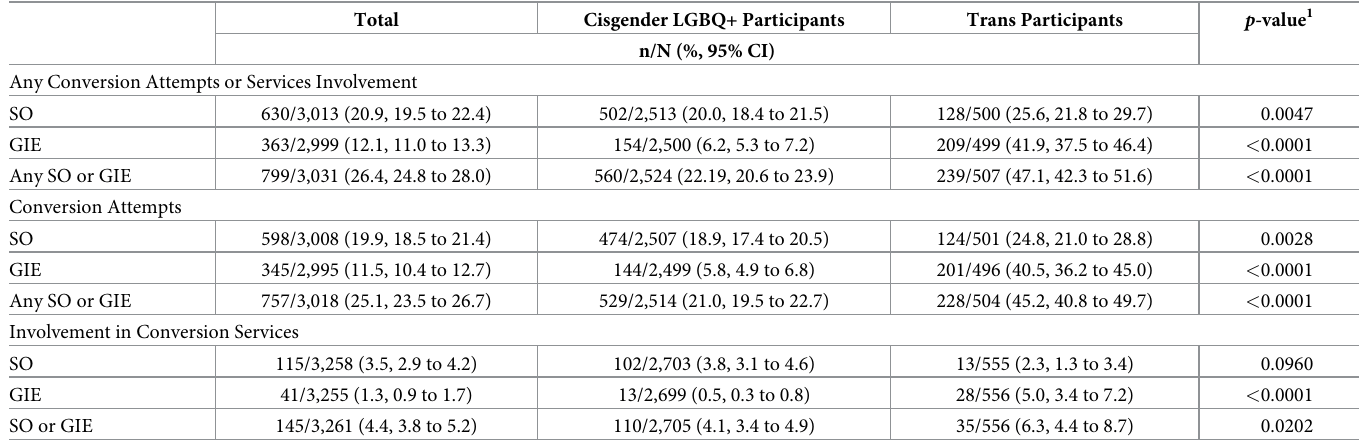
Table 3. Lifetime exposure to SOGIE conversion attempts and involvement in conversion